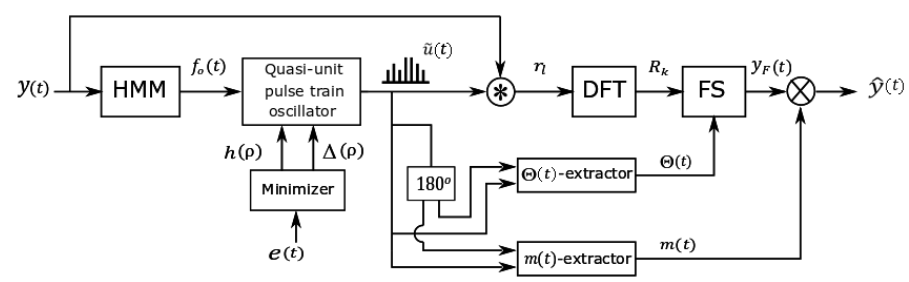
Figure 4. The modified version of the analyzer used for modelling GAWs, modified from [20]. A Fourier synthesizer (FS) uses the extracted instantaneous phase Θ(t) and the Fourier coefficients 𝑅 𝑘 obtained from pulse shapes 𝑟 𝑙 to model the input GAW. The